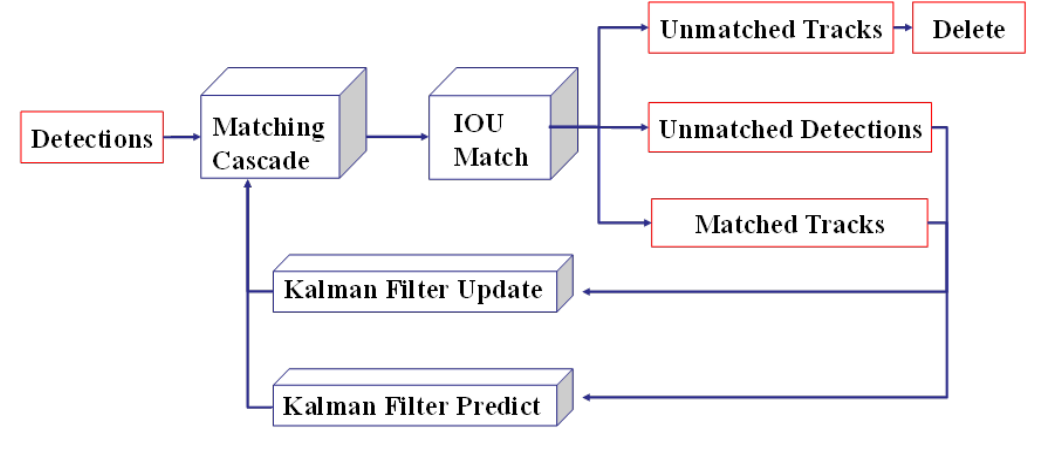
Figure 6. Architecture of DeepSORT.